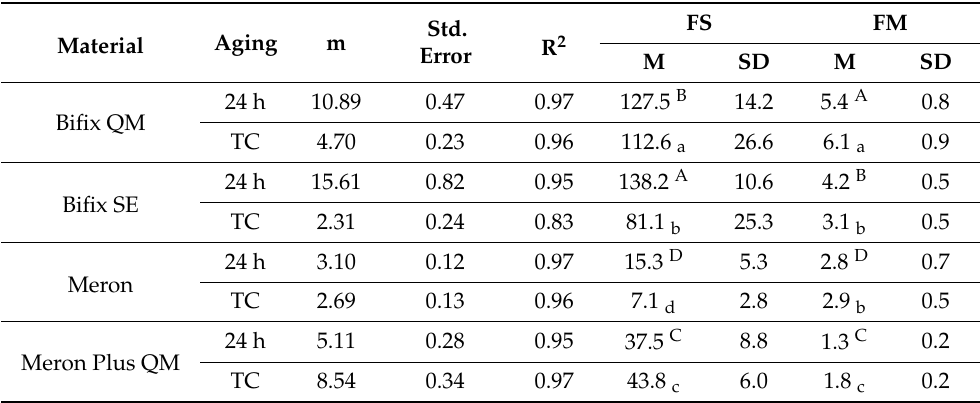
Table 2. Three-point bending test: Weibull modulus m with standard error (Std. Error) and R square ( R 2 ) values, flexural strength FS , flexural modulus FM (mean M and standard deviation SD ). Superscript (subscripts) letters indicate homogeneous groups in 24 h (TC) groups; Tukey’s post hoc test ( α =